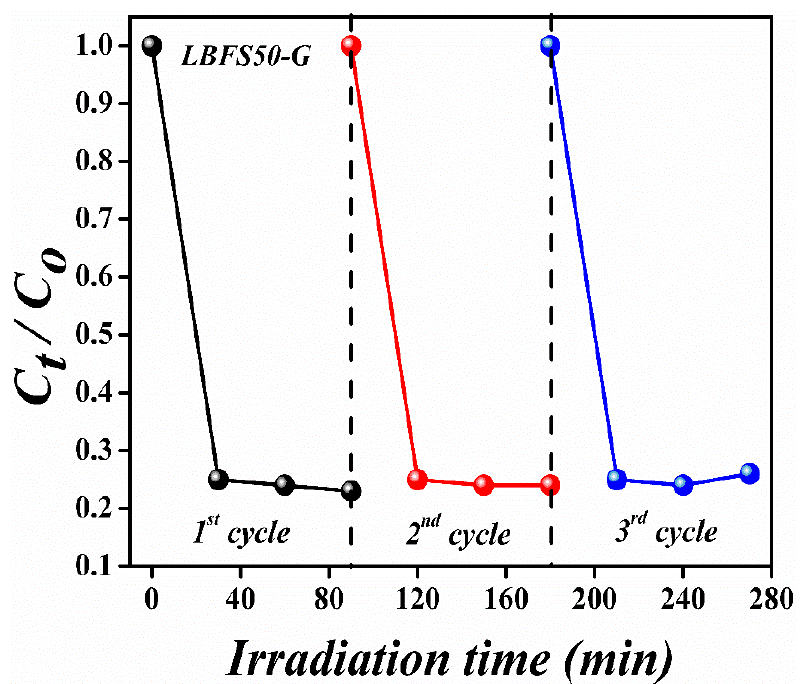
Figure 8. The re-cyclic graph for LBFSe50–G after three cyclic runs under visible-light.